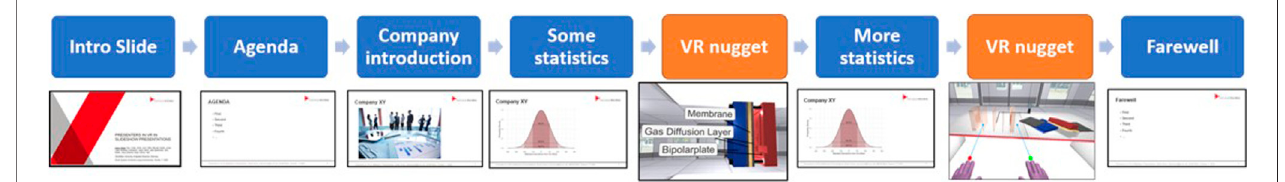
FIGURE 2 | An example presentation structure to illustrate the application of VR nuggets in education.